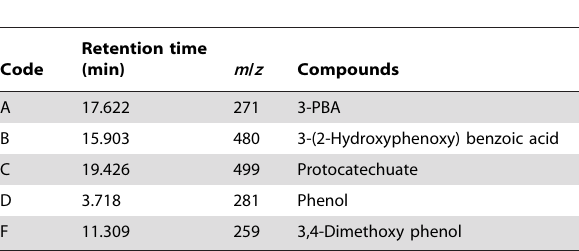
Table 4. Chromatographic properties of metabolites of 3-PBA degraded by strain DG-02.